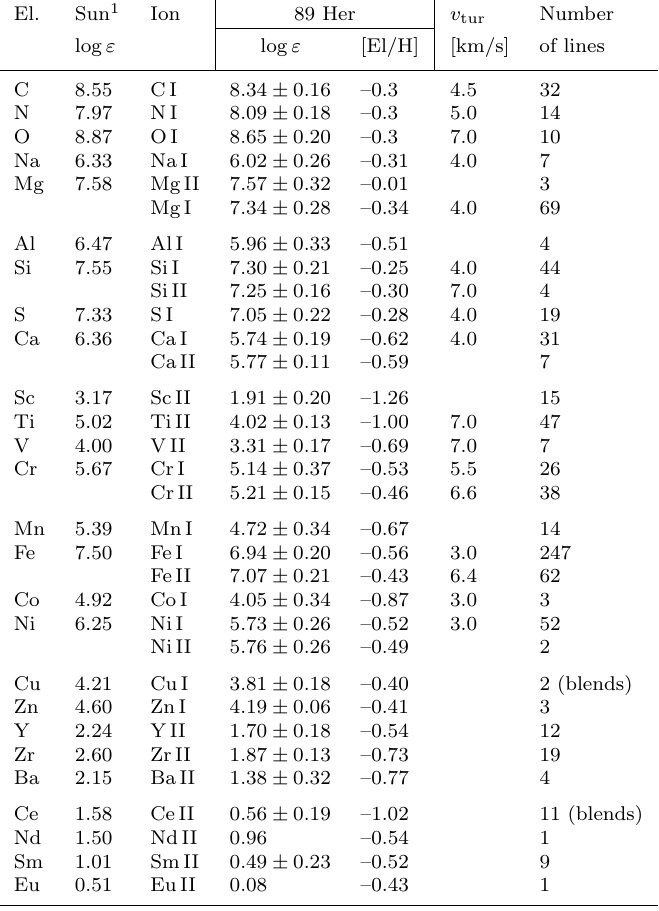
Table 2. Chemical composition of 89 Her. The derived microturbulent velocities and the number of used lines are indicated.